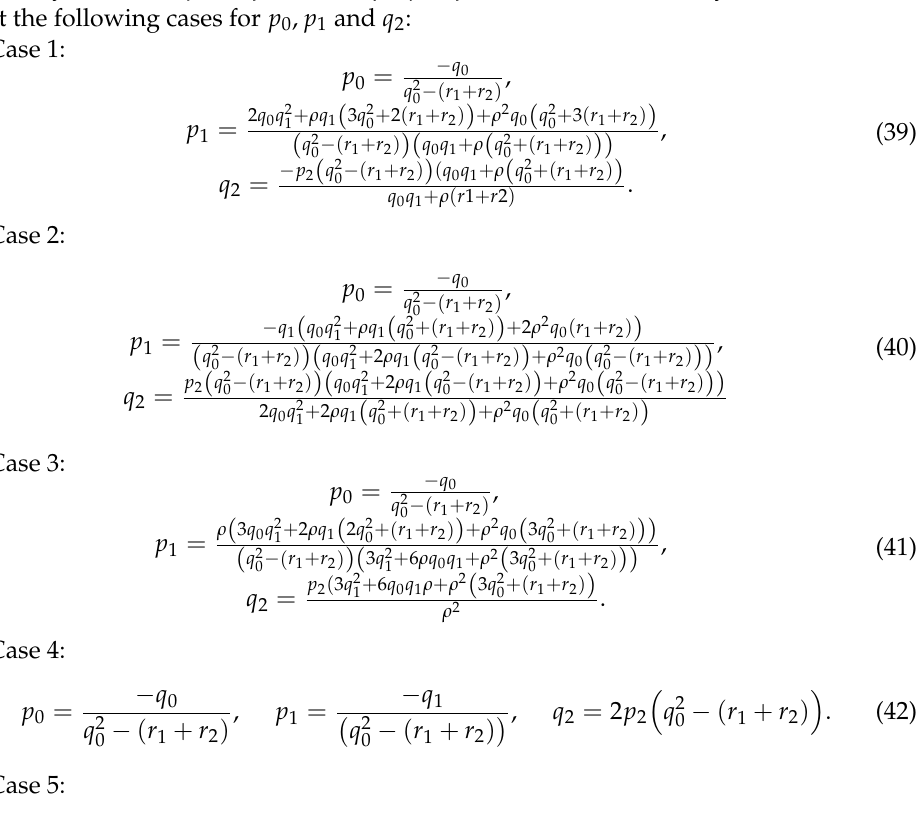
Figure 5. The 3D plots of the real and imaginary parts of F 7 ( x , t ) and G 7 ( x , t ) with the parameters r 1 = r 2 = 0.3, k 1 = k 2 = 1, q 0 = 0.9, p 3 = 4, q 1 = 5/7, ρ = 1 and τ = 0 for the fractional 0.65